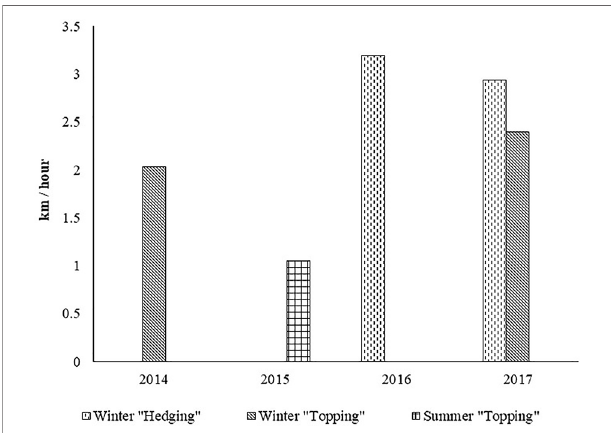
FIGURE 4 | Estimated speed of advance of the tractor with the disk pruning machine is shown as a function of the type of cut.